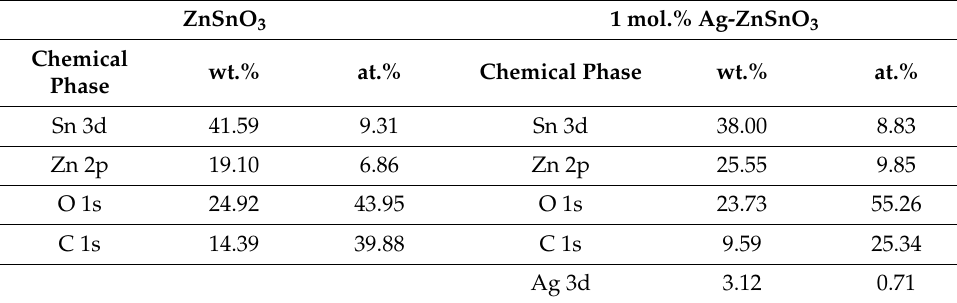
Table 2. XPS elemental chemical phase composition of synthesized material samples.